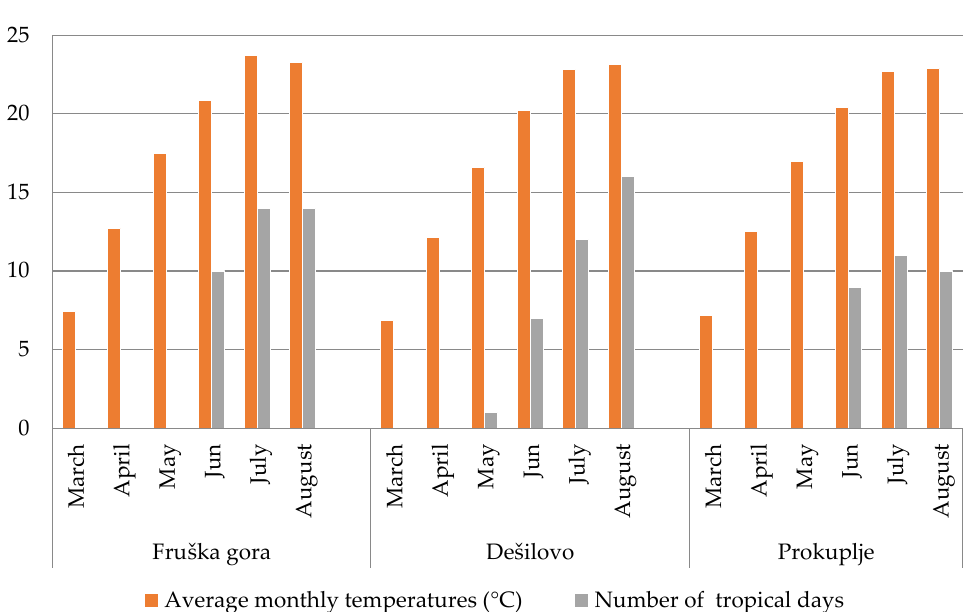
Figure 4. Variation of average monthly temperatures and number of very hot days with maximum temperatures > 30 °C during the March–August period of 2010.